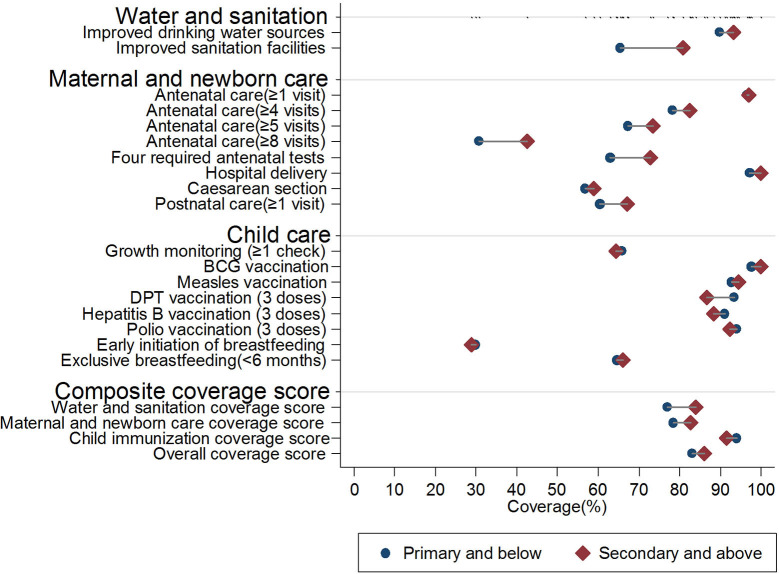
Equity gaps between low and high educational achievements in essential MNCH interventions, Jilin province, China (2008–2018). For details of the regression results for each specific intervention, please see Appendix 4.
In the water and sanitation domain, the interventions were adjusted for setting, household economic status, time to the nearest health facility, household head educational achievement, health insurance coverage, and ethnicity.In the maternal and newborn domain, the interventions were adjusted for setting, household economic status, time to the nearest health facility, mother's educational achievement, health insurance coverage, age when giving birth, parity, and ethnicity.In the child care domain, the interventions were adjusted for setting, household economic status, household head educational achievement, time to the nearest health facility, children's health insurance, age in months, sex, and ethnicity.Hospital delivery and BCG vaccination were not adjusted because the proportions were near 100%.